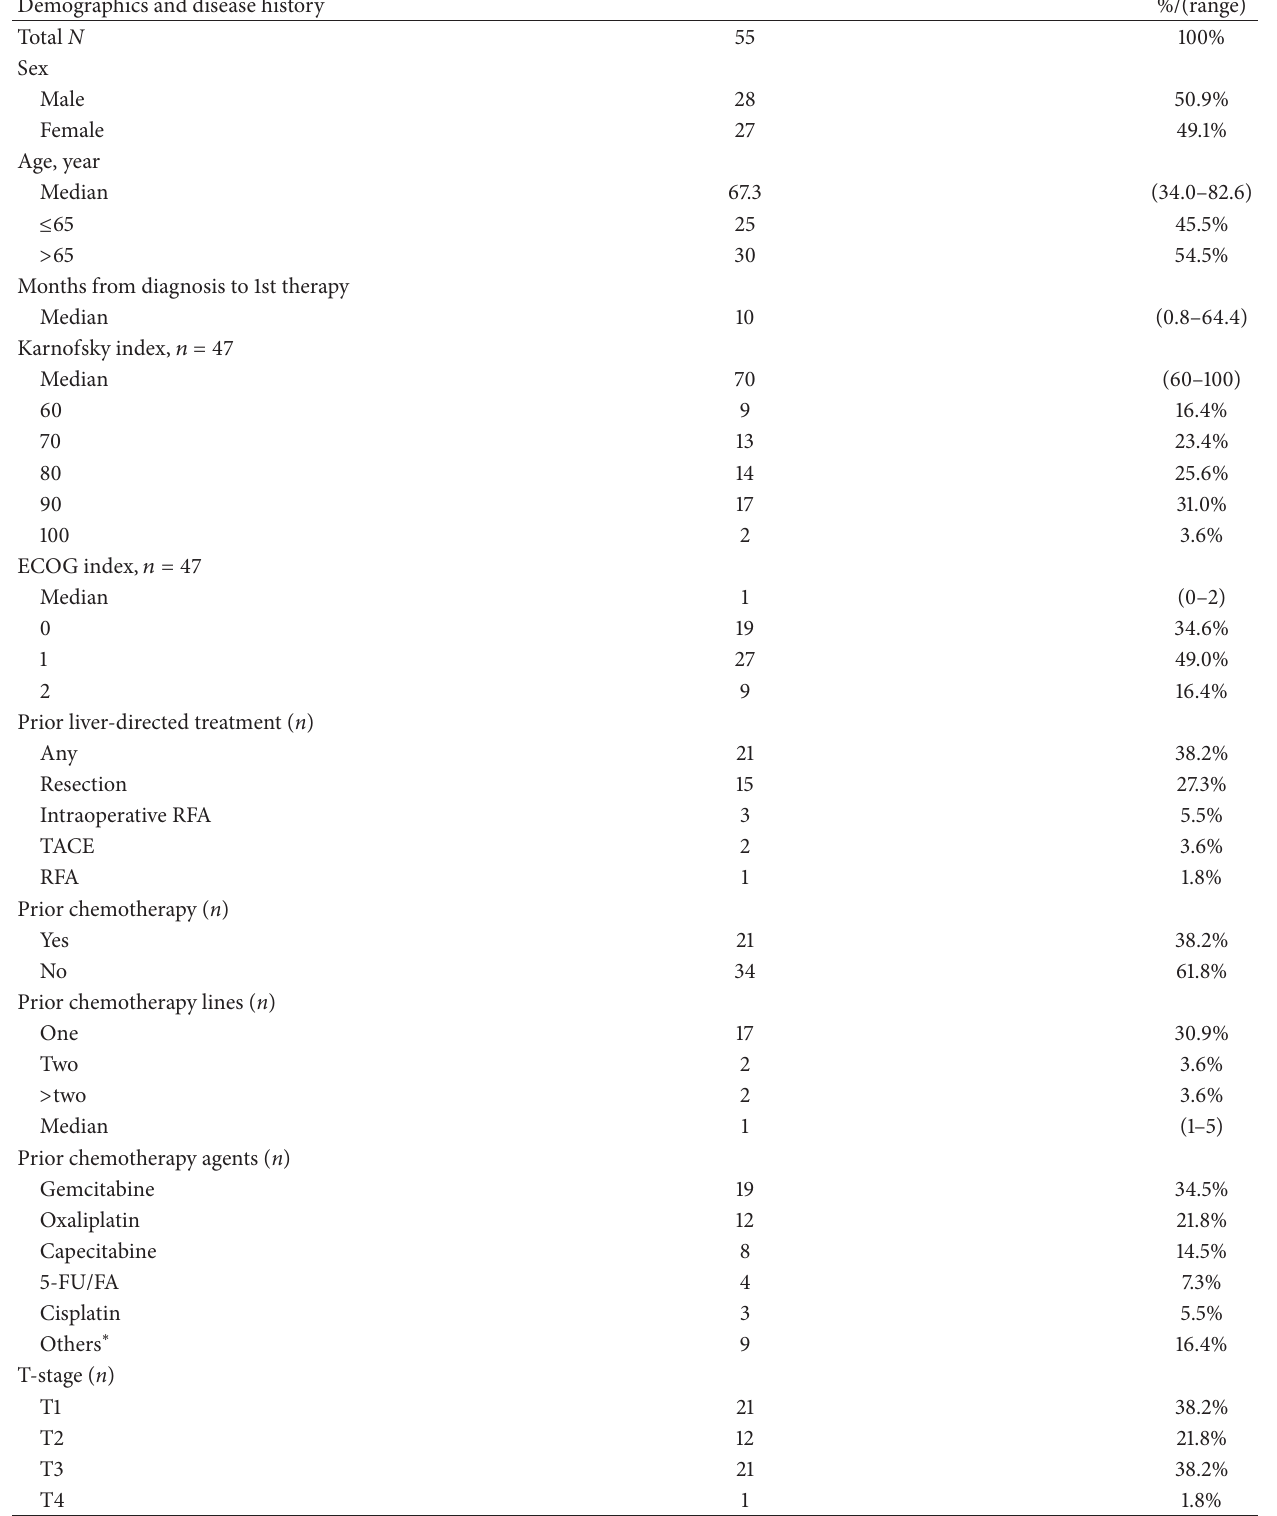
Table 1: Patients’